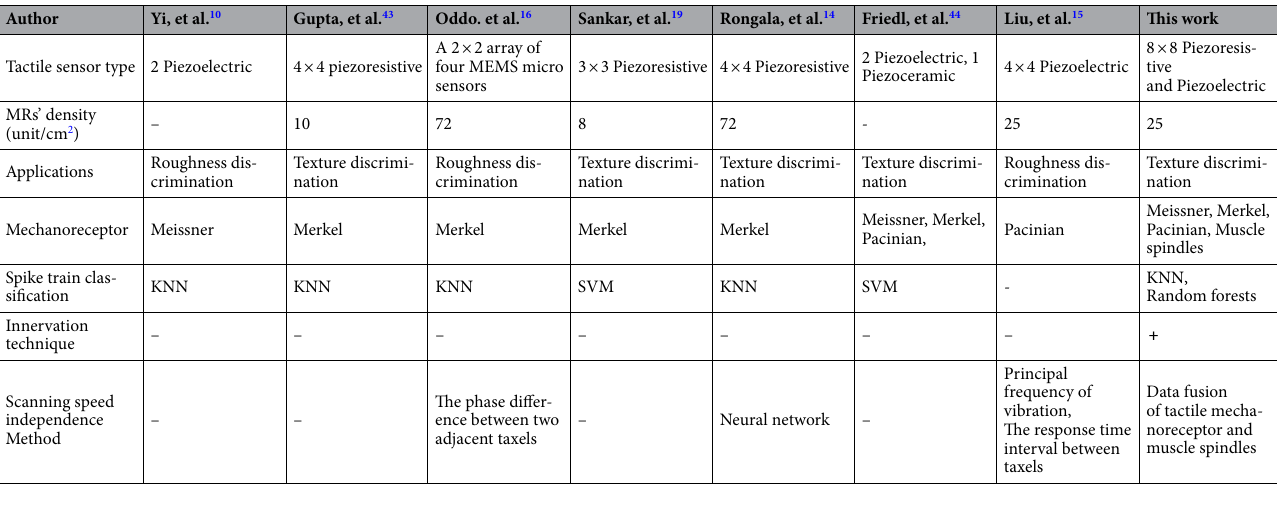
Table 1. Tactile sensing using neuromorphic methods. (MR: